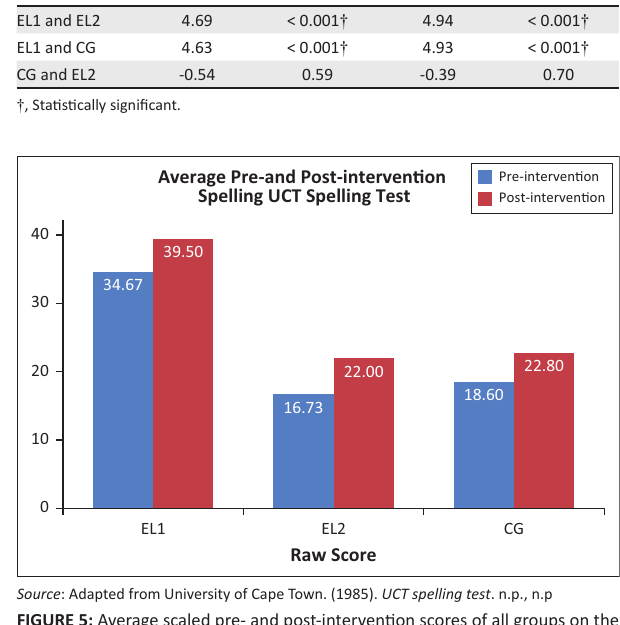
FIGURE 4: Average scaled scores of reading accuracy of all participants across all groups. TABLE 7: Results of t -tests for significant differences in pre- and post-intervention scores on reading accuracy assessment within groups. Groups